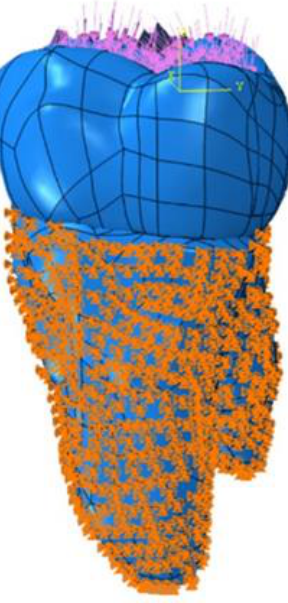
Figure 4. Molar tooth model (load and boundary conditions).